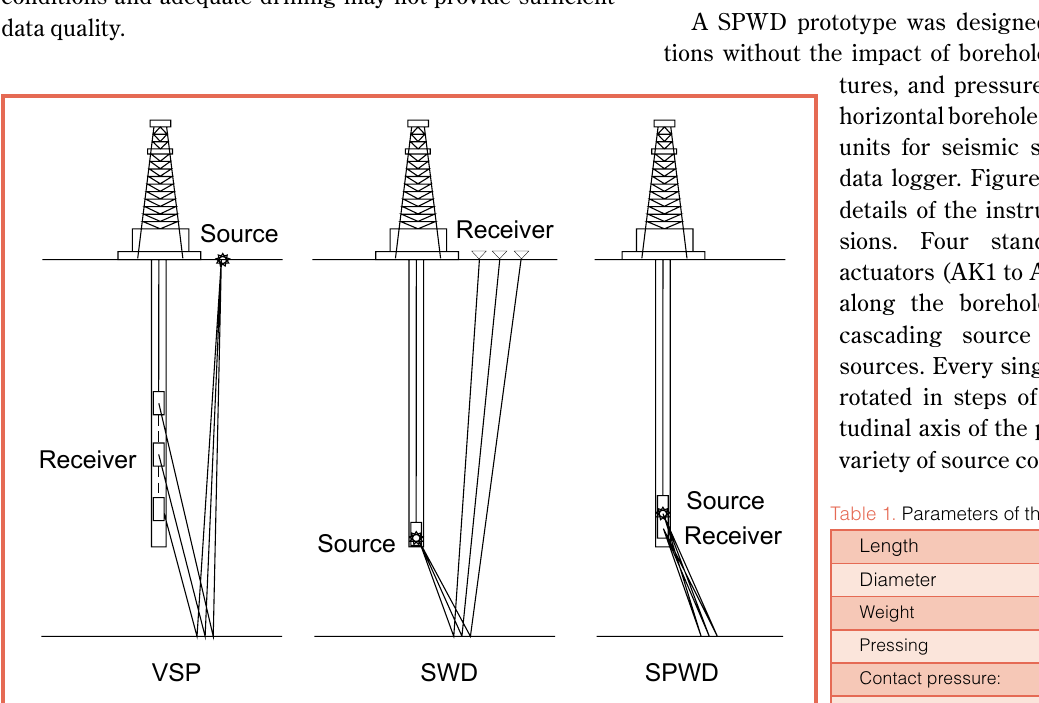
Figure 1. Comparison of the different seismic borehole exploration methods VSP, SWD, and SPWD